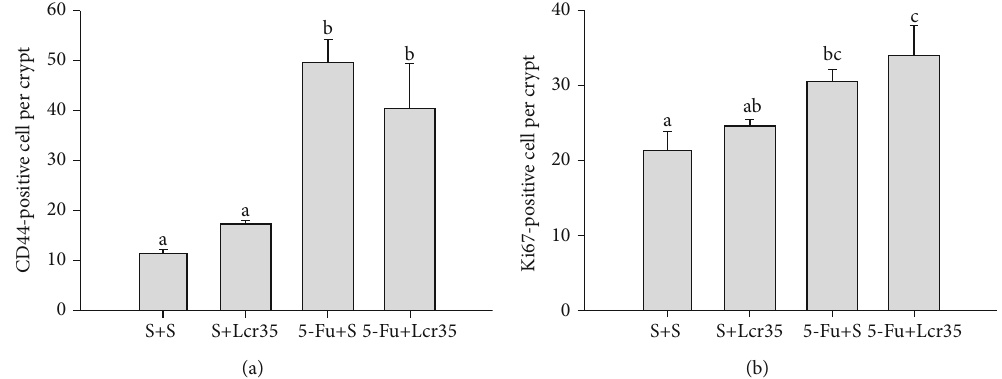
Figure 5: E ff ects of Lcr35 on CD44-positive stem cells and Ki67 proliferative cells in the intestinal mucosa. CD44-positive (a) and Ki67 (b) cells after staining were counted per crypt. 5-FU signi fi cantly stimulated the expression of CD44, and the expression was restored by administration of Lcr35, though not to the S+S or S+Lcr35 levels. 5-FU increased the number of Ki67-positive cells, but there were no signi fi cant di ff erences between the 5-FU+S and S+S groups and the 5-FU+S and 5-FU+Lcr35 groups. Values were represented as mean ± SEM and were analyzed using one-way